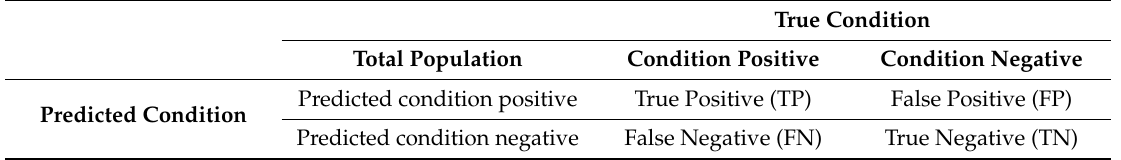
Table 3. Confusion matrix of two-class classification.